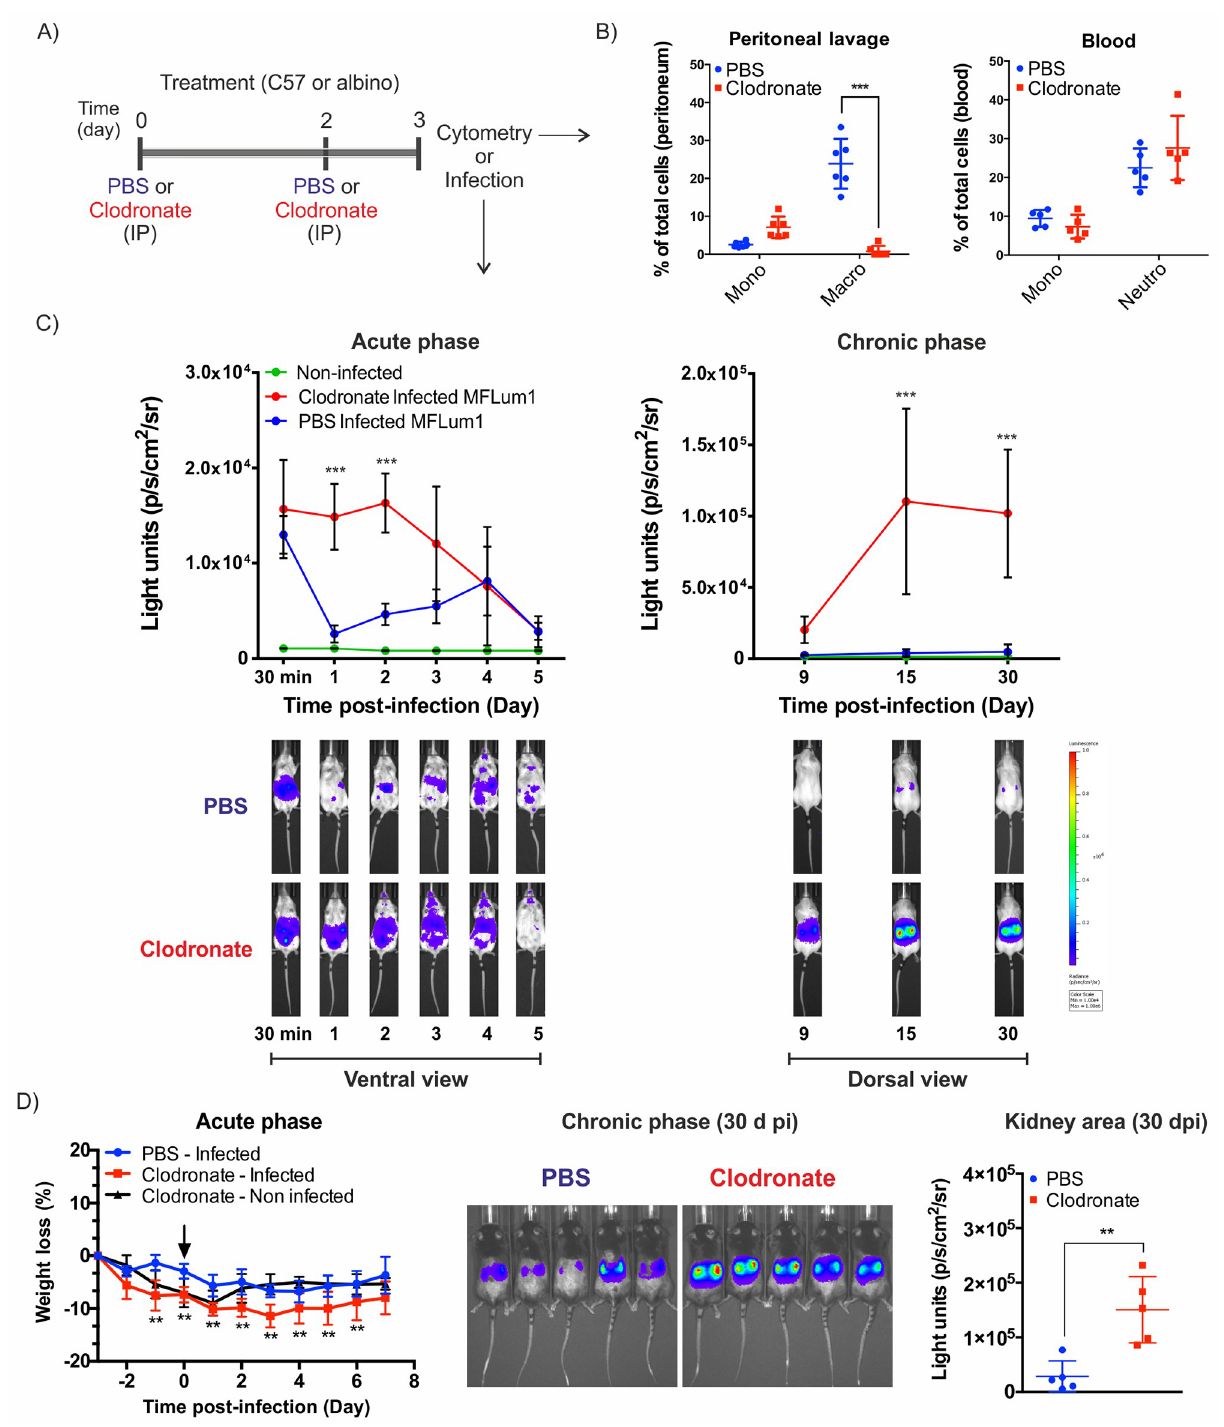
Fig 1. Macrophage intraperitoneal depletion leads to a nonlethal increase in leptospiral burden. A) Chronogram of macrophage depletion treatment. Mice were injected IP with 100 μ L liposomes containing PBS or 5 mg/mL clodronate 3 and 1 days before cytometry analysis or IP infection. B) Flow cytometry analysis and quantification of cell subset changes in the peritoneal lavage and blood of PBS- and clodronate-treated mice ( n = 6). Graphs represent the percentage of monocytes, macrophages and neutrophils in the peritoneum and blood (see full gating S1A Fig). C) Live imaging of albino (C57BL/6 B6(Cg)-Tyr c-2J /J) mice treated with PBS- or clodronate-containing liposomes and IP infected with a sublethal dose of 1x10 7 bioluminescent L . interrogans serovar Manilae strain MFlum1. During the acute phase of infection, the mice were imaged daily (ventral view) from day 0 (30 min post- infection) to day 5. During the chronic phase from day 9, mice were imaged in the dorsal view to measure renal colonization. The lower panel shows a representative example of the follow-up of one mouse. The upper panel shows the quantification of data from n = 5 mice. The blue to red scale is proportional to the intensity of bioluminescence, reflecting the number of live leptospires. D) C57BL/6 WT mice treated with PBS- or clodronate-